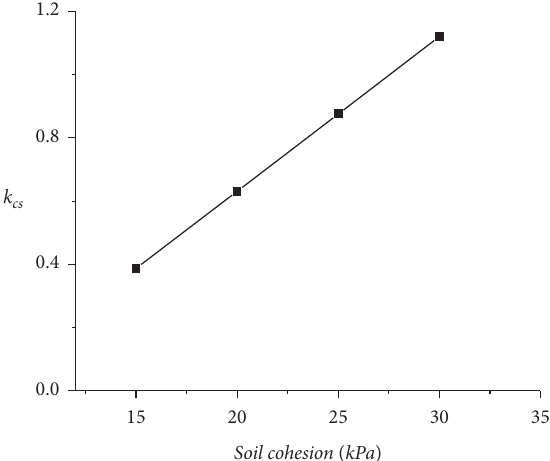
Figure 19: Variation in the yield acceleration coefficient with soil